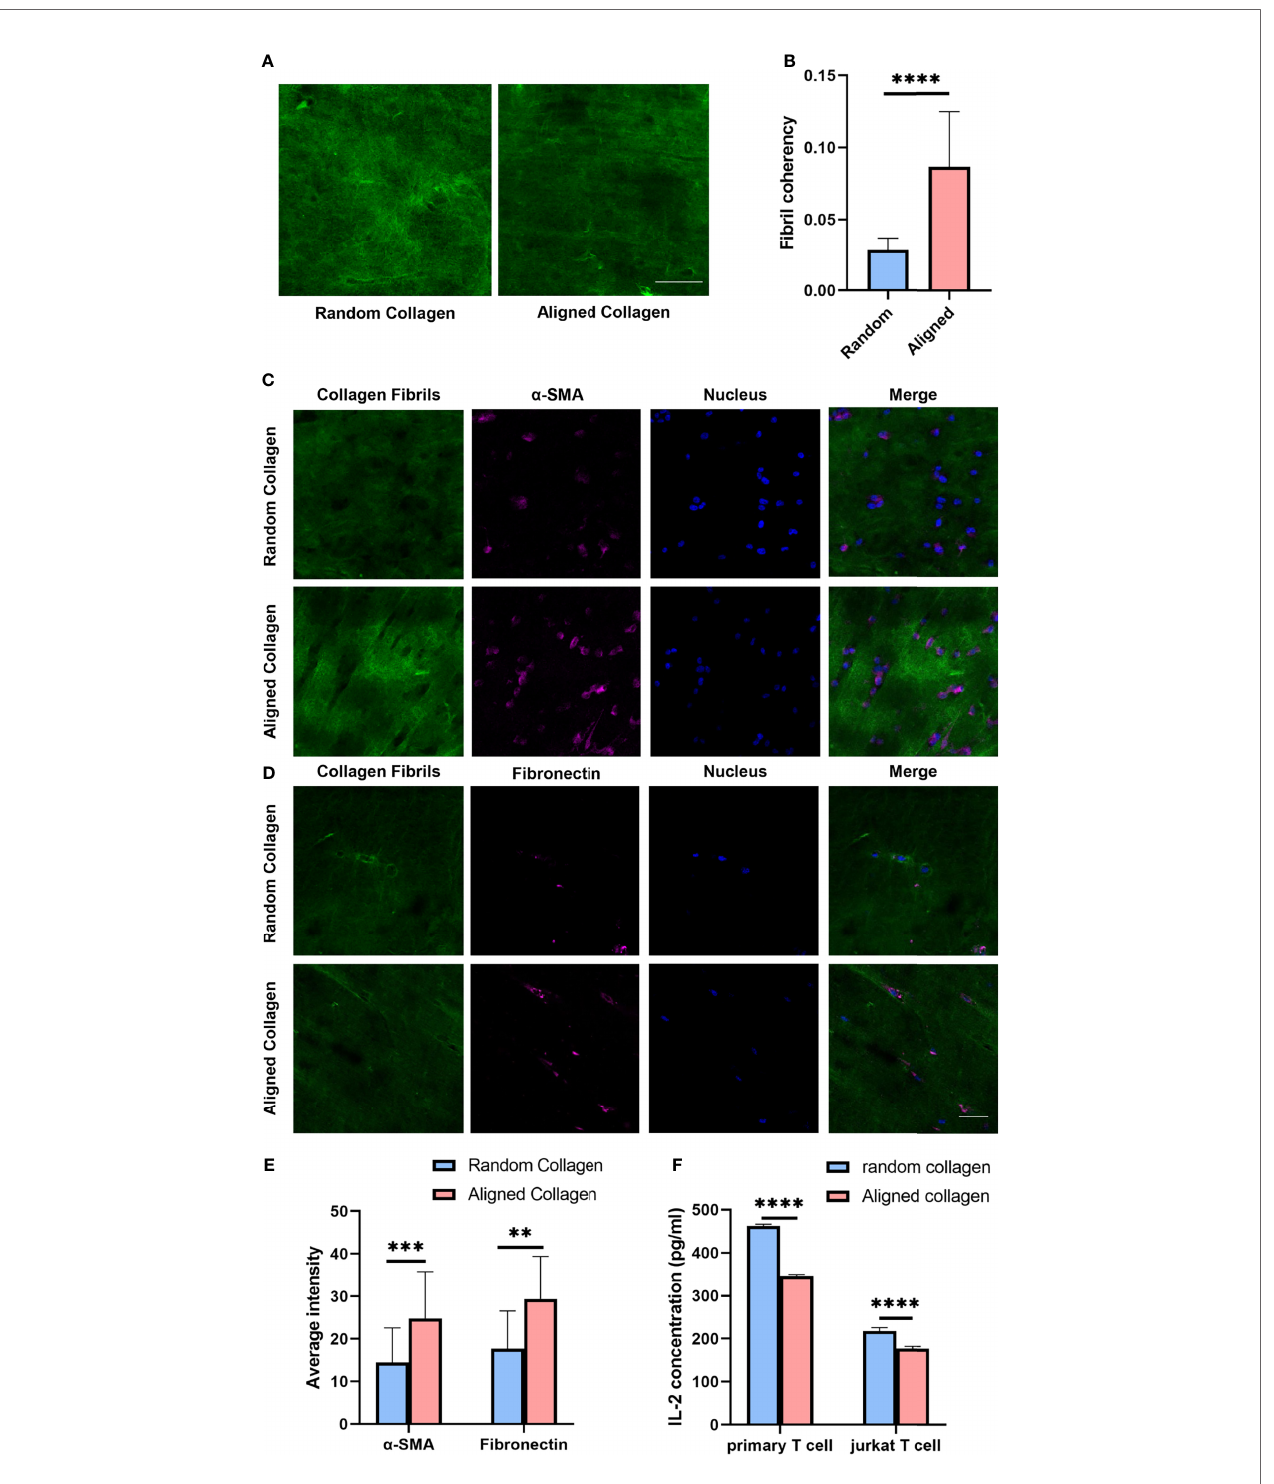
FIGURE 6 | Aligned collagen matrix enhances CAF induction and inhibit T cell activation. (A) Random and aligned collagen fi brils were successfully conducted by magnetic stretching. (B) Fibril coherency between the random and aligned groups. (C) Immuno fl uorescence staining of a -SMA of MRC-5 cells encapsulated in random and aligned collagen fi brils. (D) Immuno fl uorescence staining of fi bronectin of MRC-5 cells encapsulated in random and aligned collagen fi brils. (E) Average fl uorescence intensity of a -SMA and fi bronectin between random and aligned groups. (F) IL-2 levels of activated primary T cells and Jurkat T cells encapsulated in random and aligned collagen fi brils. (scale bar, 50 m m). ** P < 0.01; *** P < 0.001, **** P <